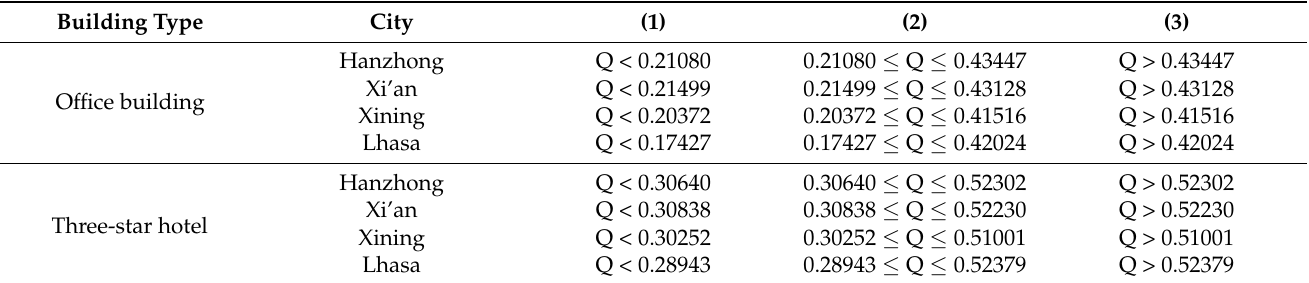
Table A4. Results of regional division of two types of buildings using